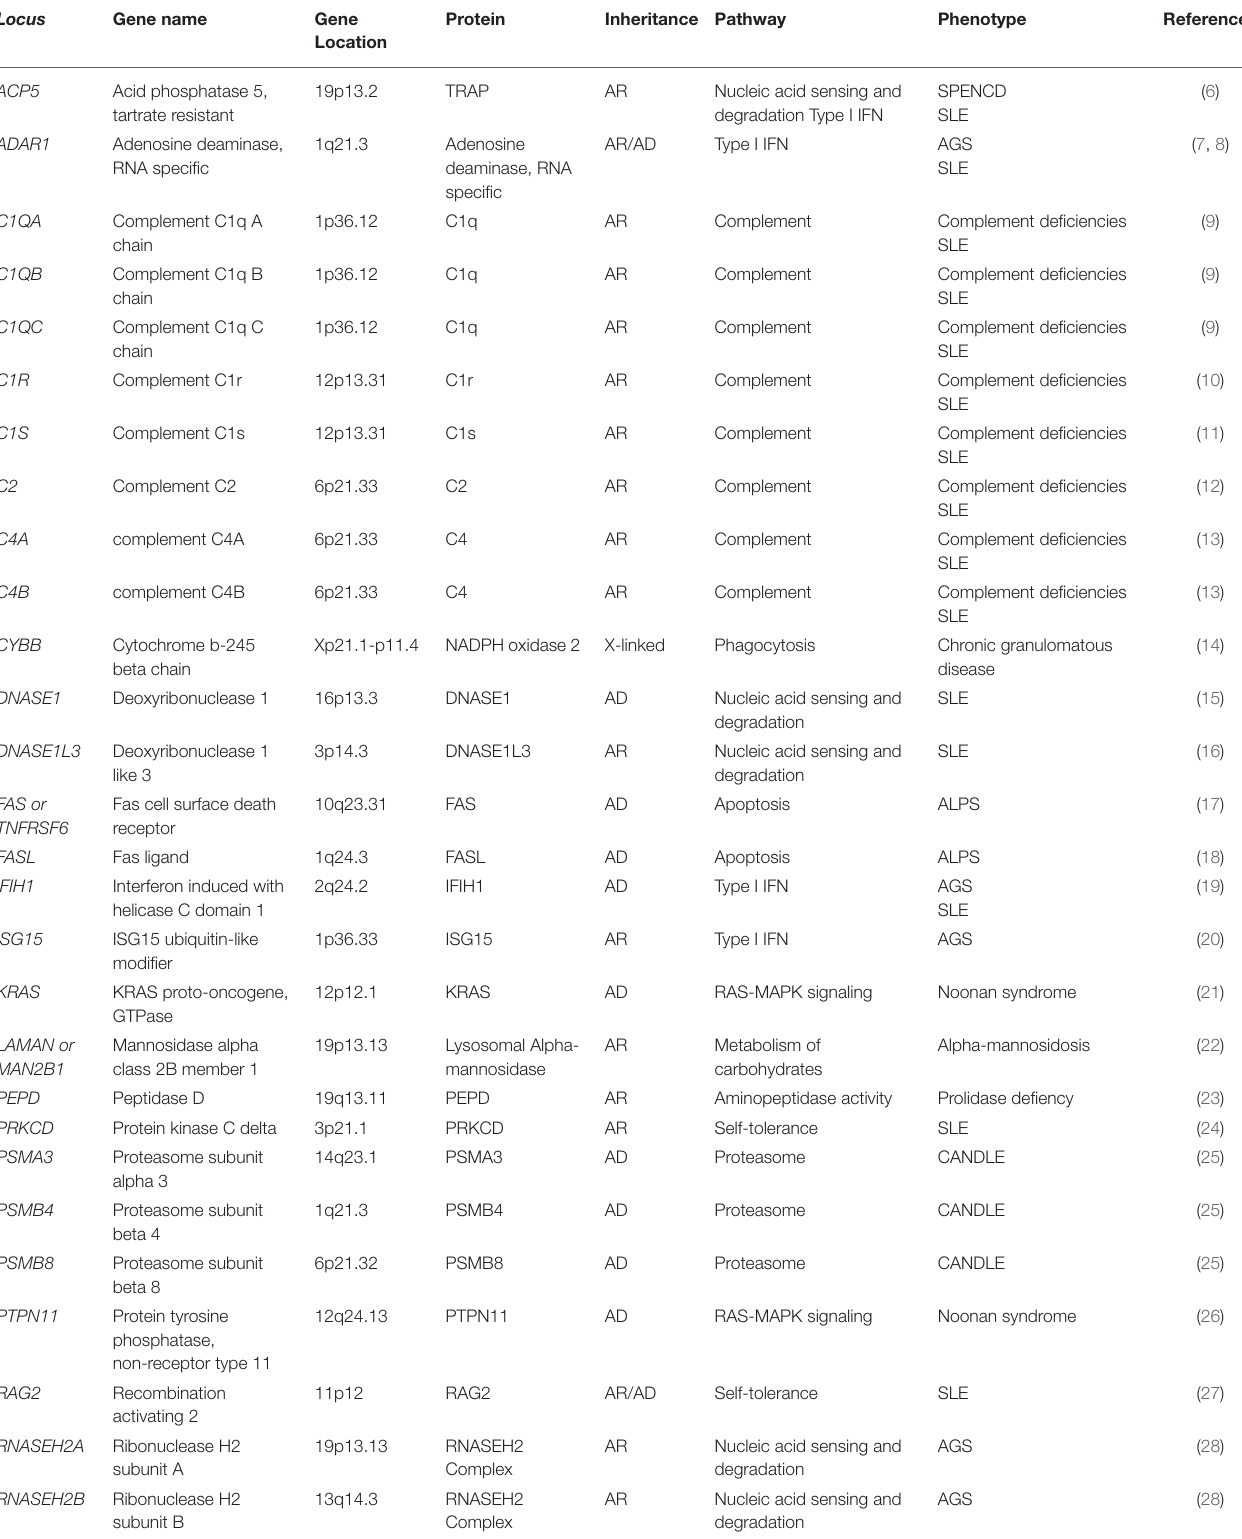
TABLE 1 | List of genes identified to cause monogenic lupus or lupus-like diseases.